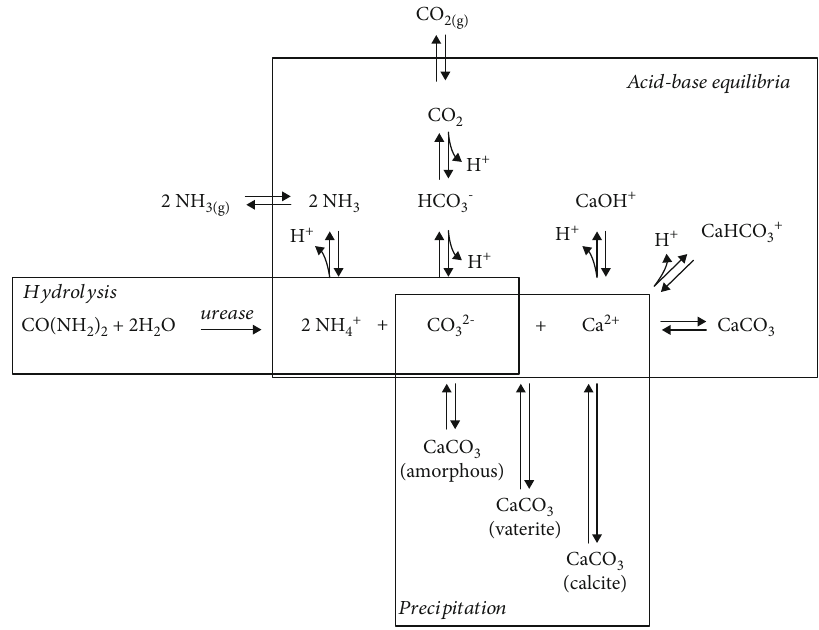
Figure 1: The biochemical process of MICP [15]. Table 1: Initial permeability and porosity of each core comprising the three grain-size